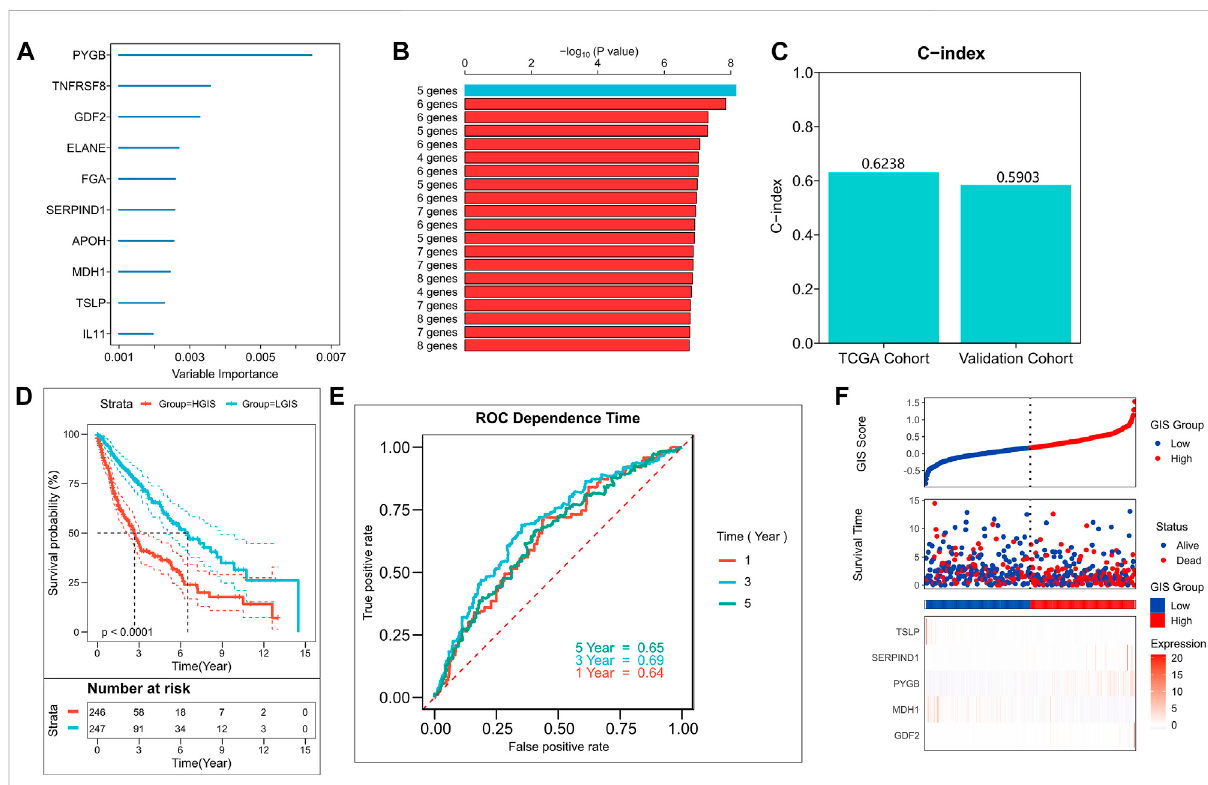
FIGURE 2 Construction of the GIS risk model. (A) Random forest screening of top10 important prognostic genes. (B) Log-rank test of p -value for each genemodel. (C) C-indexofthebestmodelinTCGAandGEOqueues. (D) KMsurvivalcurvesofhighandlowGISgroupsintheTCGAcohort. (E) ROC curves of GIS in the TCGA cohort at 1, 3, 5, and 8 years (F) Survival status and model gene expression of patients in the TCGA cohort. GEO, Gene Omnibus Expression; KM, Kaplan – Meier; ROC, receiver operating characteristics curve; GIS, glycolysis – immune score; TCGA, The Cancer Genome